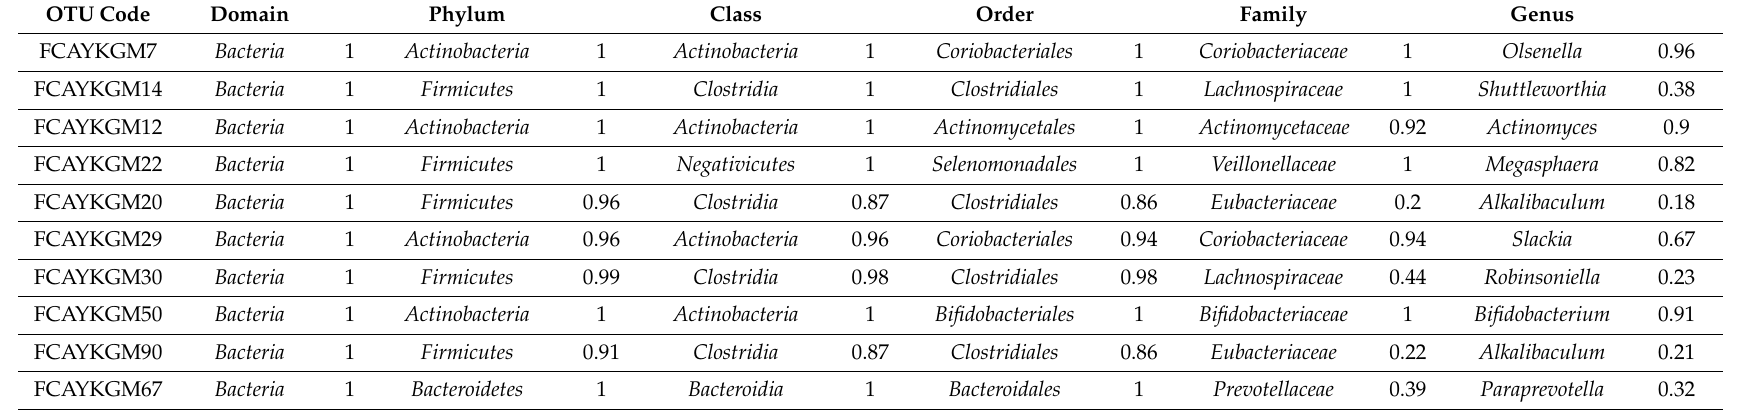
Table 1. Top 10 abundant OTUs in cecal microbiota of wild Japanese rock ptarmigans at different locations in Japanese